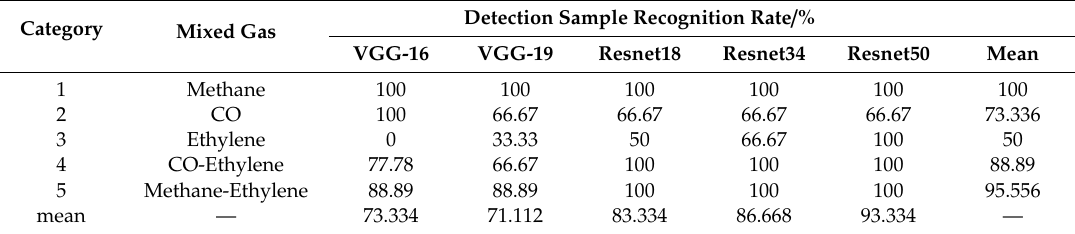
Figure 14. The samples of mixed gas in Sample-set 4 ( a ) Methane; ( b ) CO; ( c ) Ethylene; ( d ) CO-Ethylene; ( e ) Methane-Ethylene. Table 13. Identification results of VGG-16, VGG-19, Resnet18, Resnet50 and Resnet50.